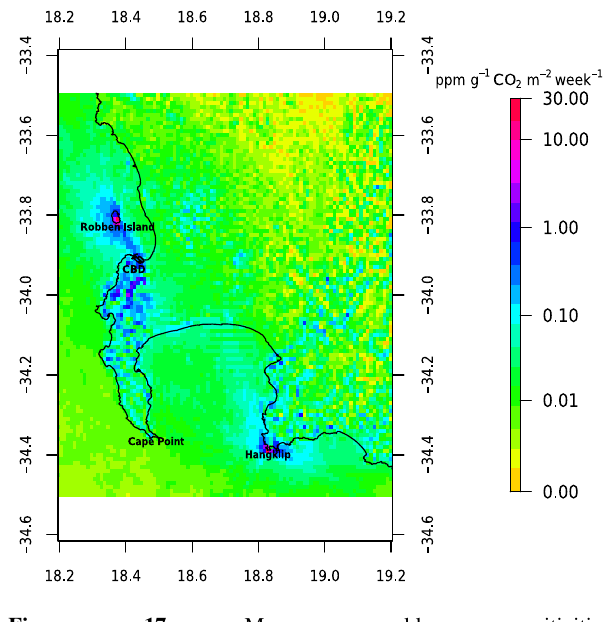
Figure 17. Mean weekly sensitivities (ppmkg − 1 CO 2 m − 2 week − 1 ) of the measurement sites at Robben Island and Hangklip to each surface source pixel, plotted on a log